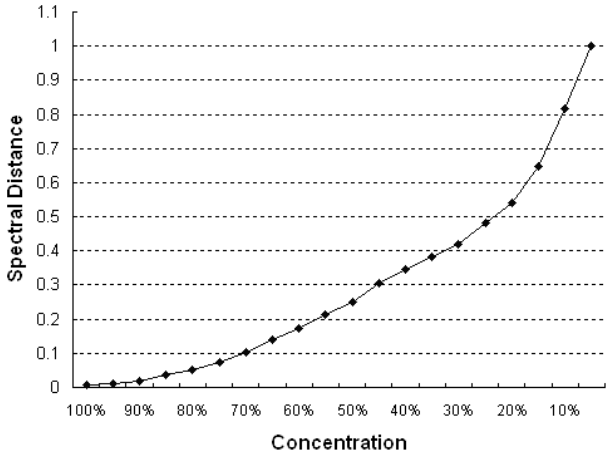
Fig. 3. Plot of spectral distances of 1,2-dihydroxypropane solutions under di®erent concentrations to the group \1,2- dihydroxypropane" in the identi¯cation model.